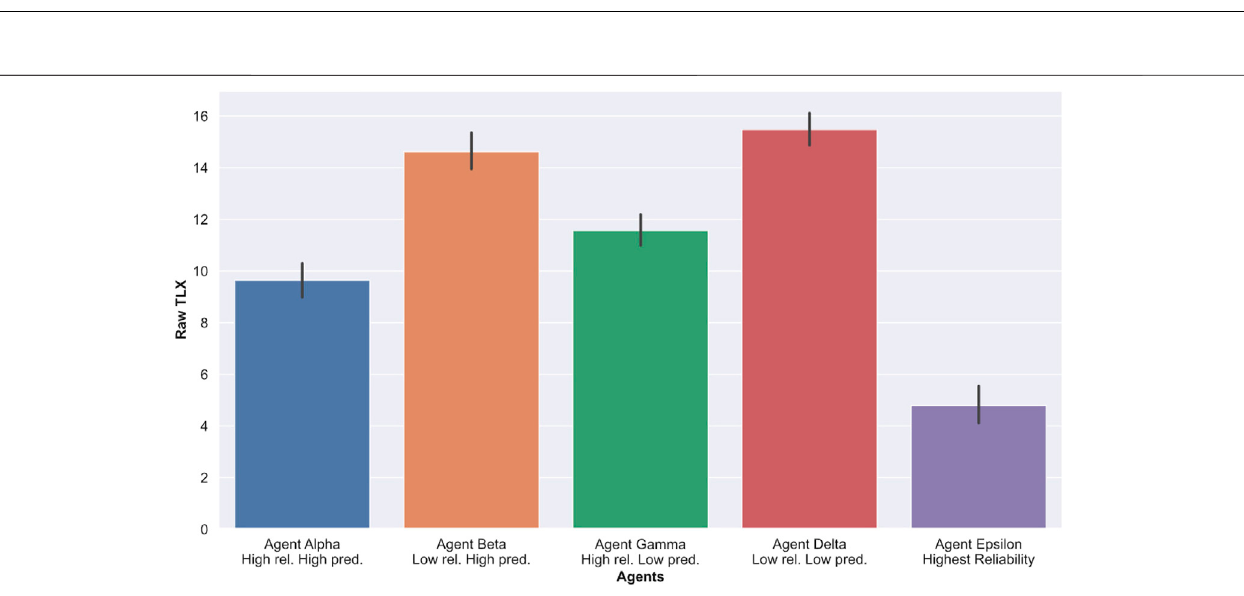
FIGURE 6 | Relationship between participants ’ Recall and Precision scores for each session (with or without agents). Each dot represents one participant.